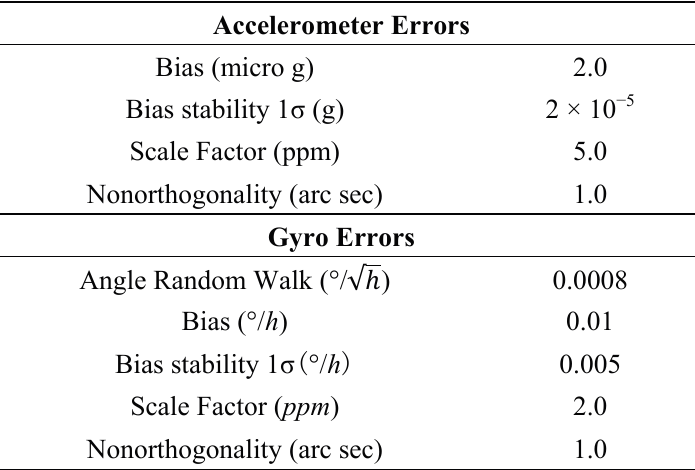
Table 4. Gyro and accelerometer